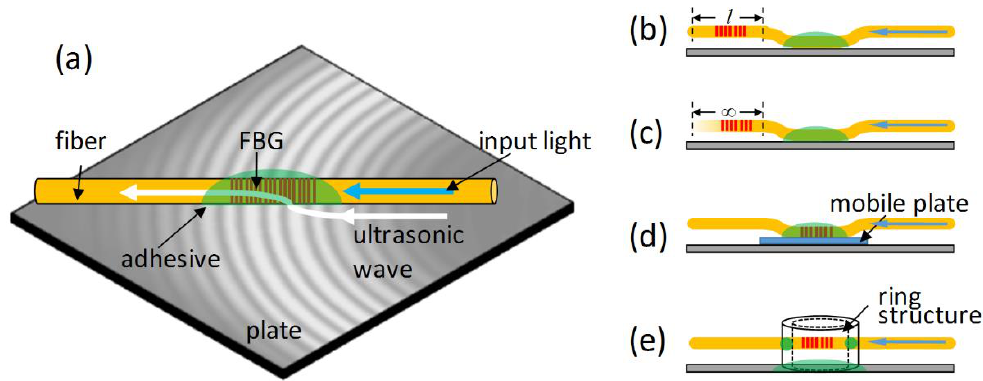
Figure 8. The FBG under the influence of an ultrasonic wave. ( a ) surface-mounted; ( b ) cantilever structure; ( c ) remote sensing; ( d ) mobile sensor; ( e ) piezo ring structure.